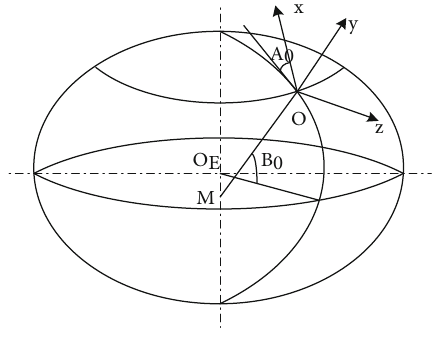
Figure 1: Launch coordinate